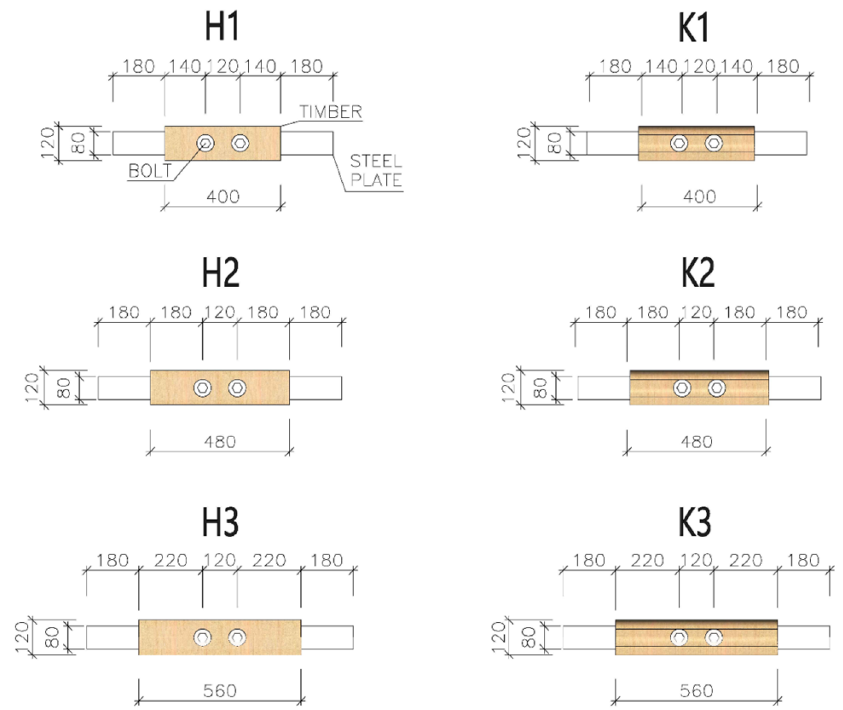
Figure 6. Types of specimens for the experimental testing.